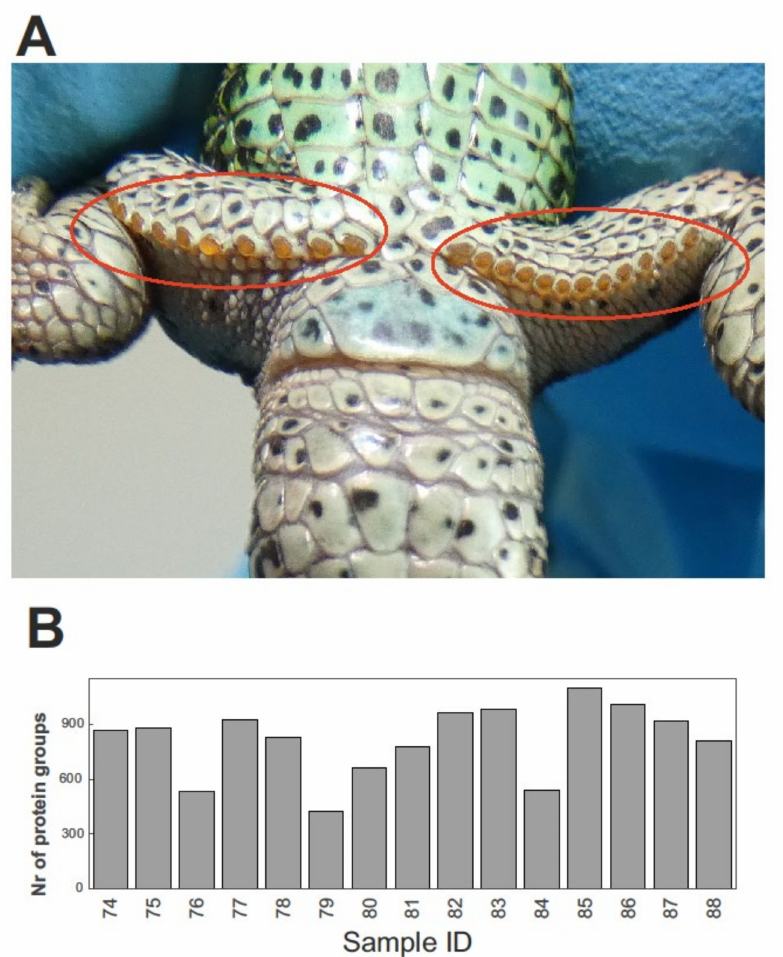
Figure 1. ( A ) Macroscopic aspect of femoral glands (highlighted with red circles) in a male sand lizard ( Lacerta agilis ). Photo by A. Ib á ñez. ( B ) Total number of proteins identified in each femoral gland sample. Numbers in the abscissa are sample ID numbers (i.e., sample